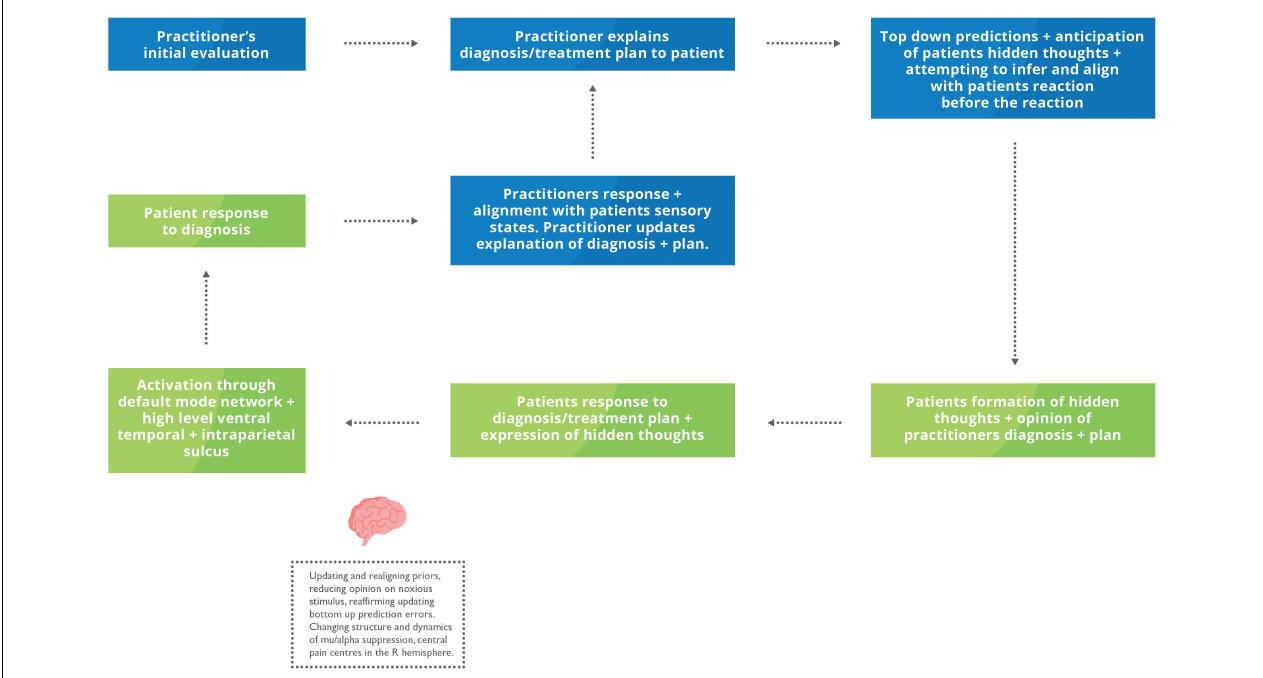
FIGURE 4 | Proposed feedback loop during an explanation of the problem and plan of care. Blue box, HCP inner mental states and actions; Green box, Patient internal mental states and actions. The HCP conducts an initial examination, often using verbal and non-verbal communication – including touch to reach a summary of their evaluation and plan of care. As the practitioner communicates the outline of their assessment, they will start to mentalise their patient’s reactions and hidden throughs. The patient may begin developing hidden thoughts regarding their diagnosis before verbalising them. Based on their patient’s responses, the HCP may modify their previous explanation to achieve a more robust and collaborative description considering the patient’s